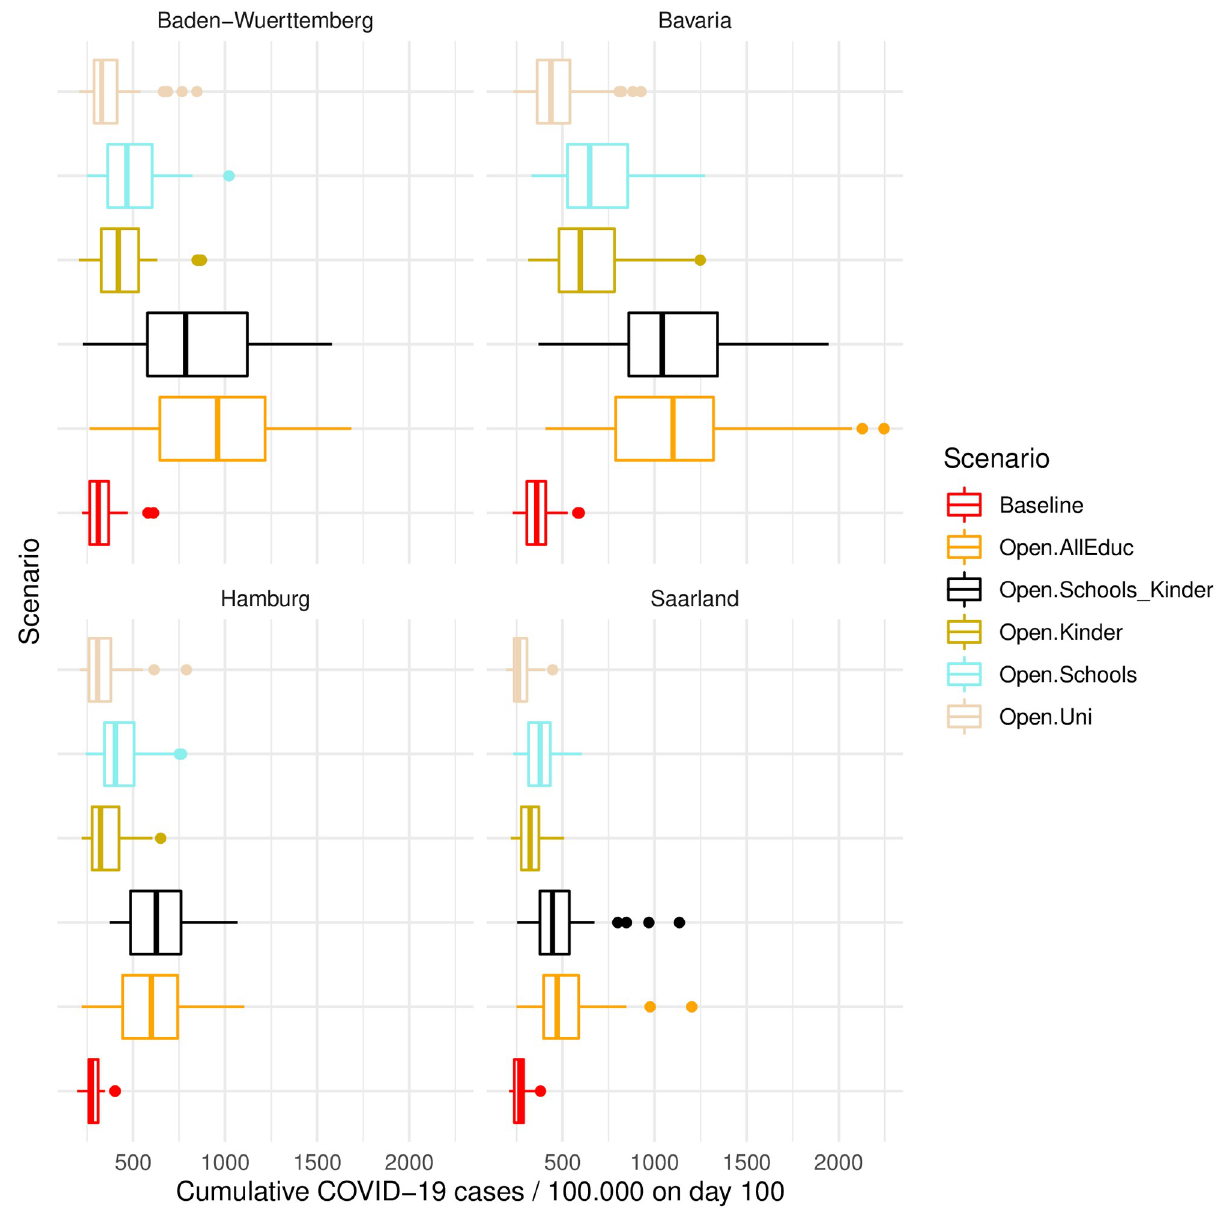
Fig 3. Cumulative infection numbers on day 100 for each counterfactual non-implementation of education-related NPIs, by state. Boxplots depict the distribution of all replications. For exact values of the average cumulative case numbers, standard deviations and confidence intervals on day 100, see also S5 and S6